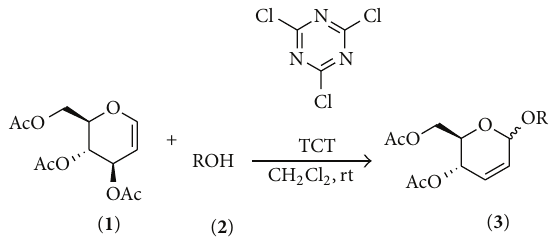
Scheme 1: Synthesis of 2,3-unsaturated O -glycosides.